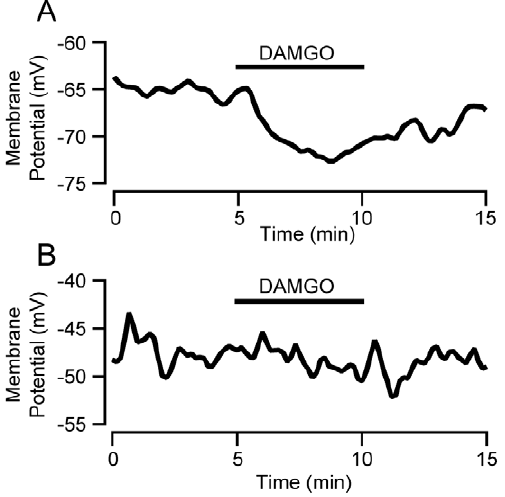
Figure 9. Some, but not all, VTA GABA neurons are inhibited by activation of the MOR. Example current clamp traces from identified VTA GABA neurons tested with bath application of 1 m M DAMGO. (A) GABA neuron showing robust inhibition by DAMGO (B) GABA neuron unresponsive to DAMGO.